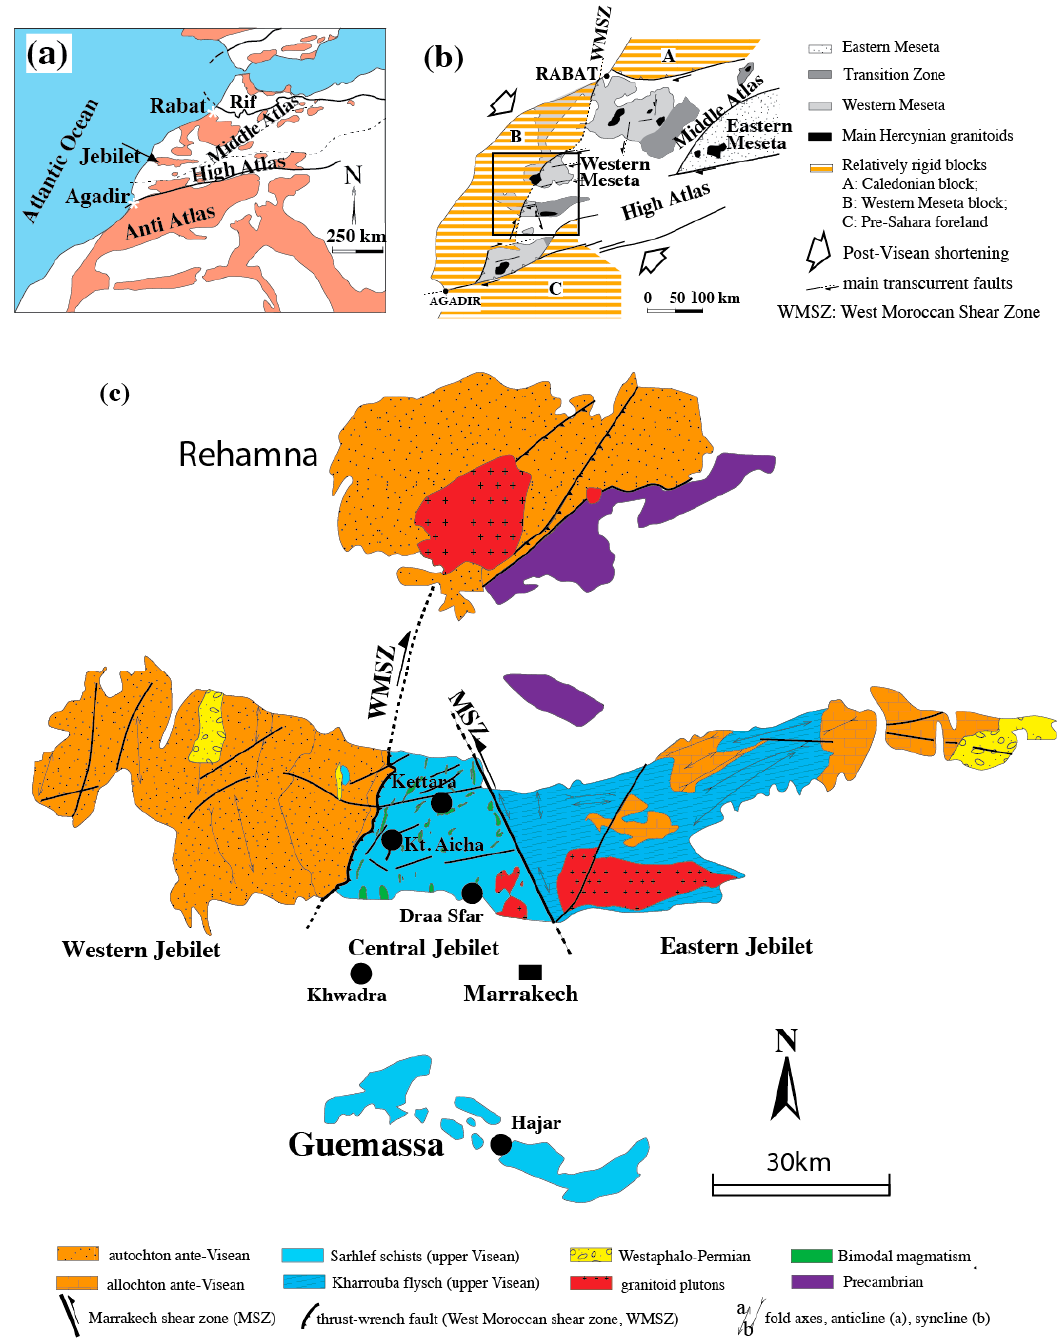
Figure 1. ( a ) Geology of the Jebilet Massif in the framework of the Paleozoic outcrops of North Africa, ( b ) Main structural zones of the Variscan Belt of Morocco (modified from [28]), and ( c ) General geological map of the Rehamna, Jebilet and Guemassa massifs showing the location of the principal massive sulphide deposits (modified from [16,29]). The white color represents undifferentiated post-Paleozoic sedimentary units.